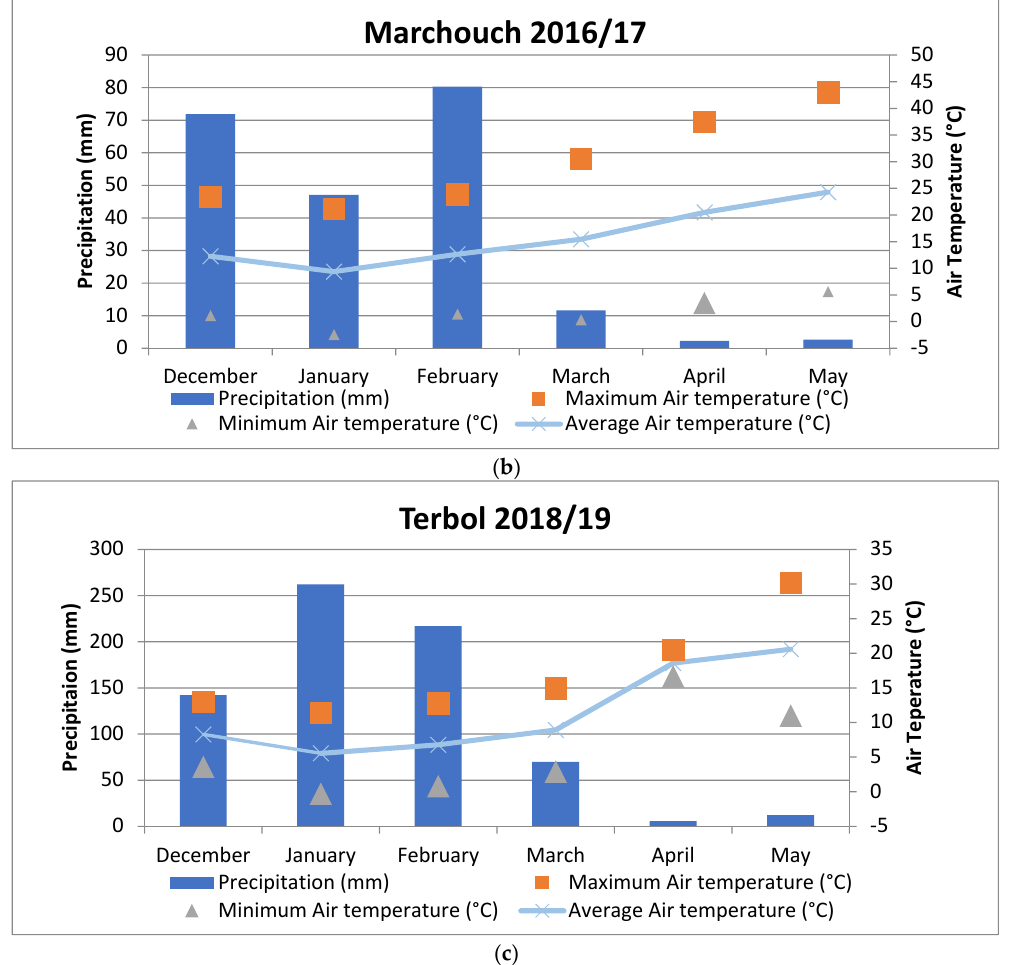
Figure 4. Precipitation (mm), average of minimum and maximum air temperature at Terbol and Marchouch during the three cropping seasons; ( a ) Marchouch 2015/16; ( b ) Marchouch 2016/17, and ( c ) Terbol 2018/19.